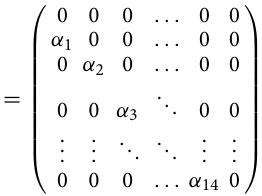
C is the contact-distribution matrix among the age groups 41 , ii = x i .